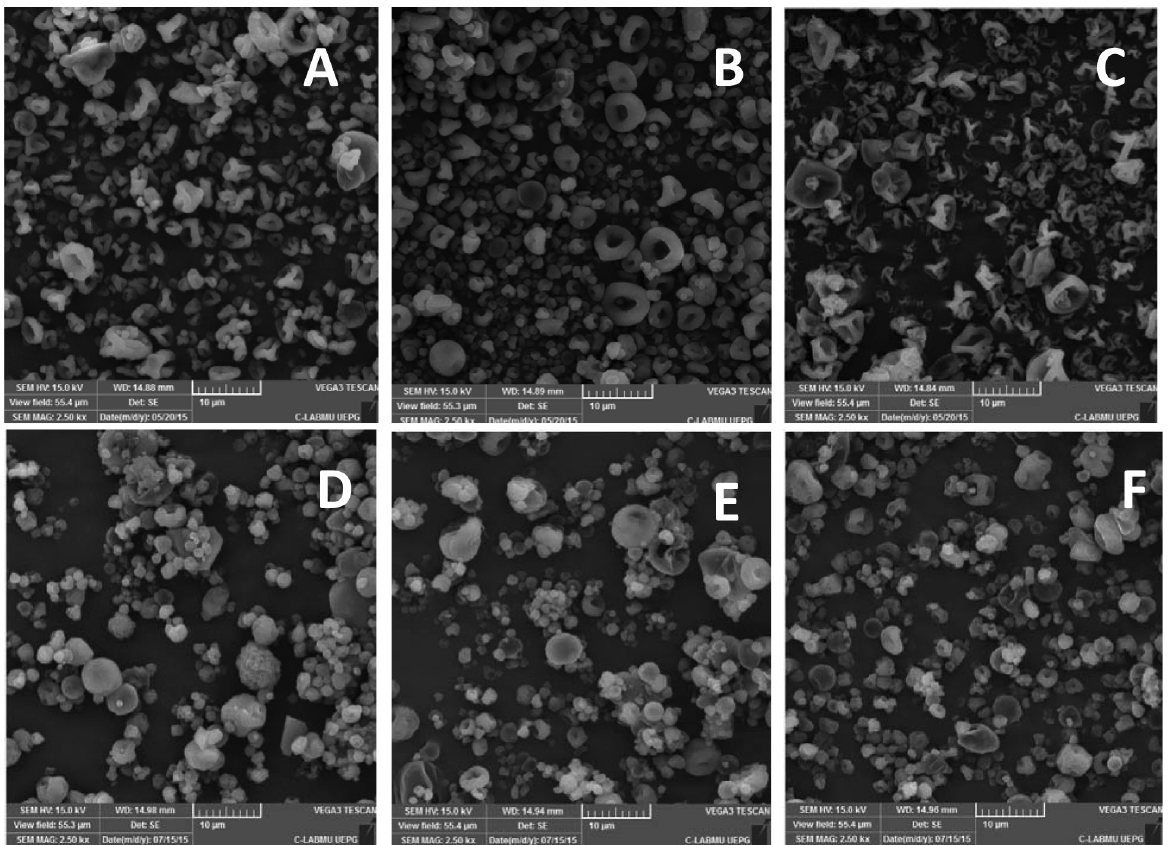
FIGURE 2 - Photomicrographs of microparticles: (A) HPMC:CS 1:1; (B) HPMC:CS 1:3; (C) HPMC:CS 3:1; (D) EC:CS 1:1; (E) EC:CS 1:3; (F) EC:CS 3:1 (magnification of 2,500 x). MT: metronidazole; HPMC: hydroxypropyl methylcellulose; EC: ethylcellulose; CS: